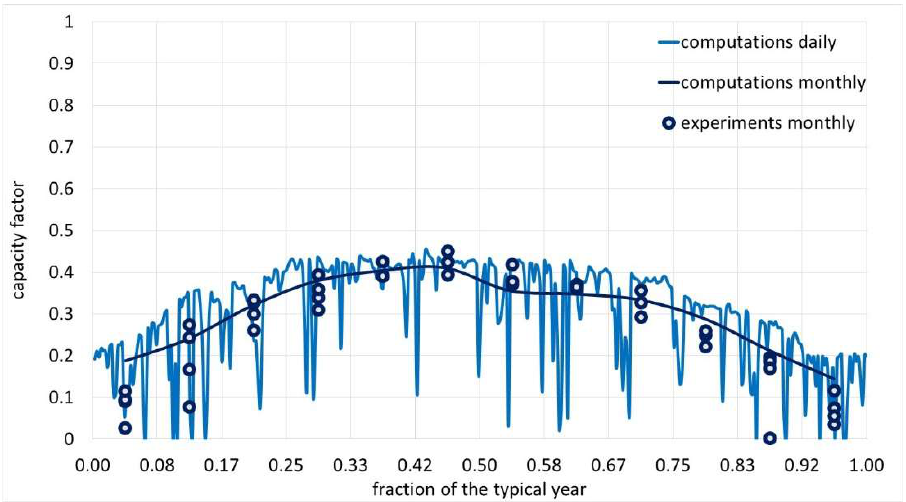
Figure 5. Genesis solar facility. Daily and monthly capacity factors from computations and monthly capacity factors from experiments. X is the fraction of the year. Y is the capacity factor. The computation is made for the typical year. The experiments are the values measured since the completion of the plant (multiple entries per month).